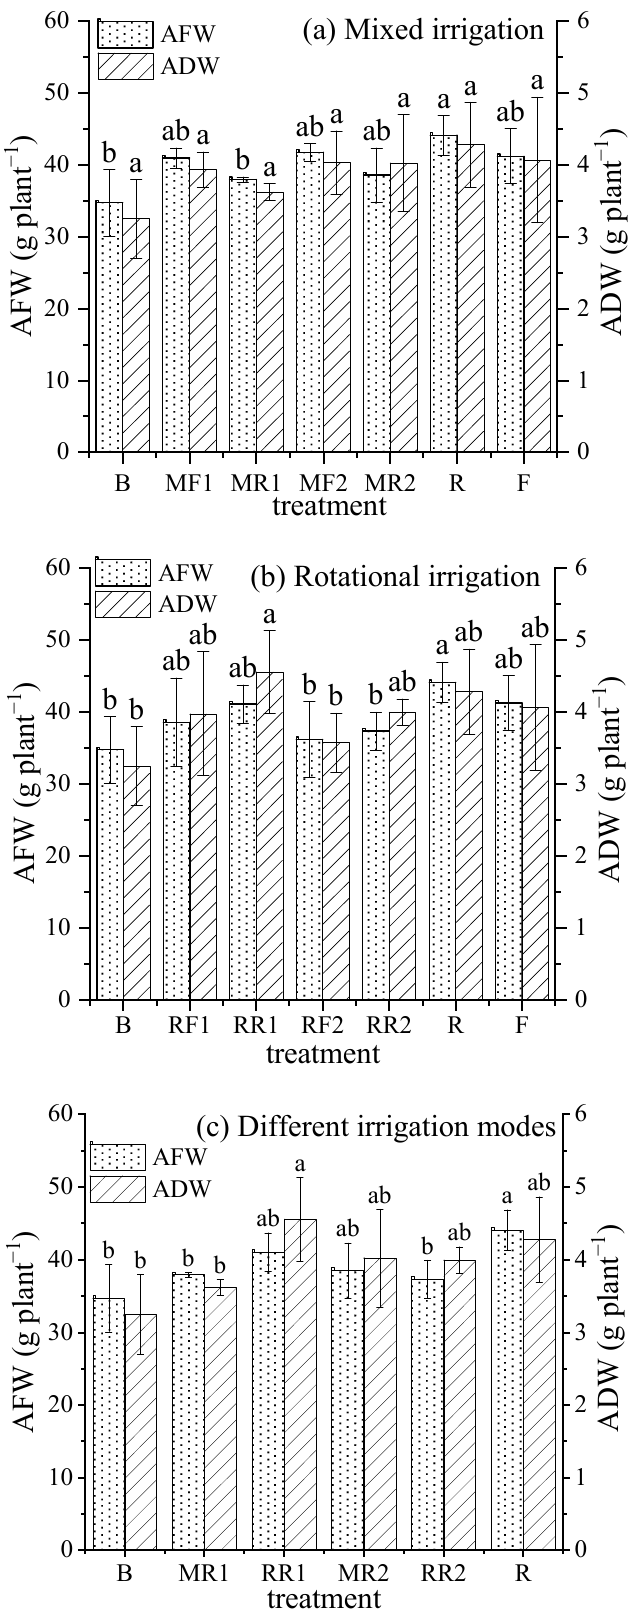
Figure 7. Variations in AFW and ADW under different irrigation scenarios. Note: different lowercase letters on the bars represent the significant differences at the level of 0.05.